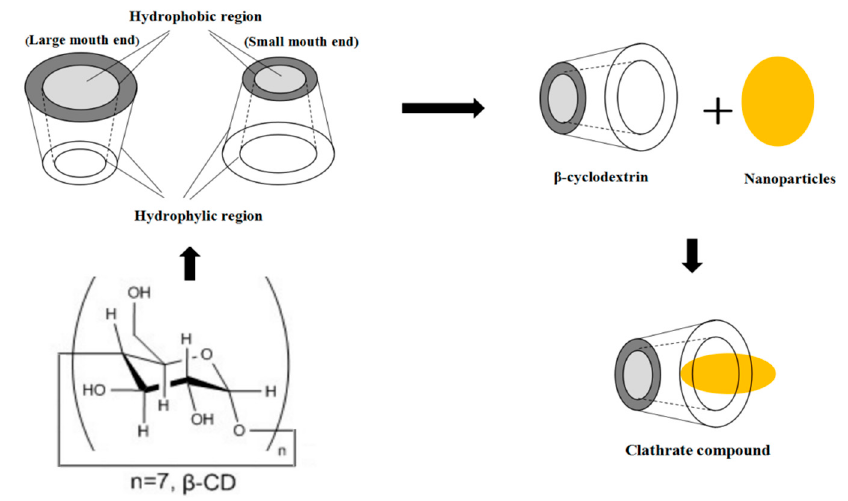
Figure 2. The structure of β -CD and the simulated enveloped process of β -CD with NPs.